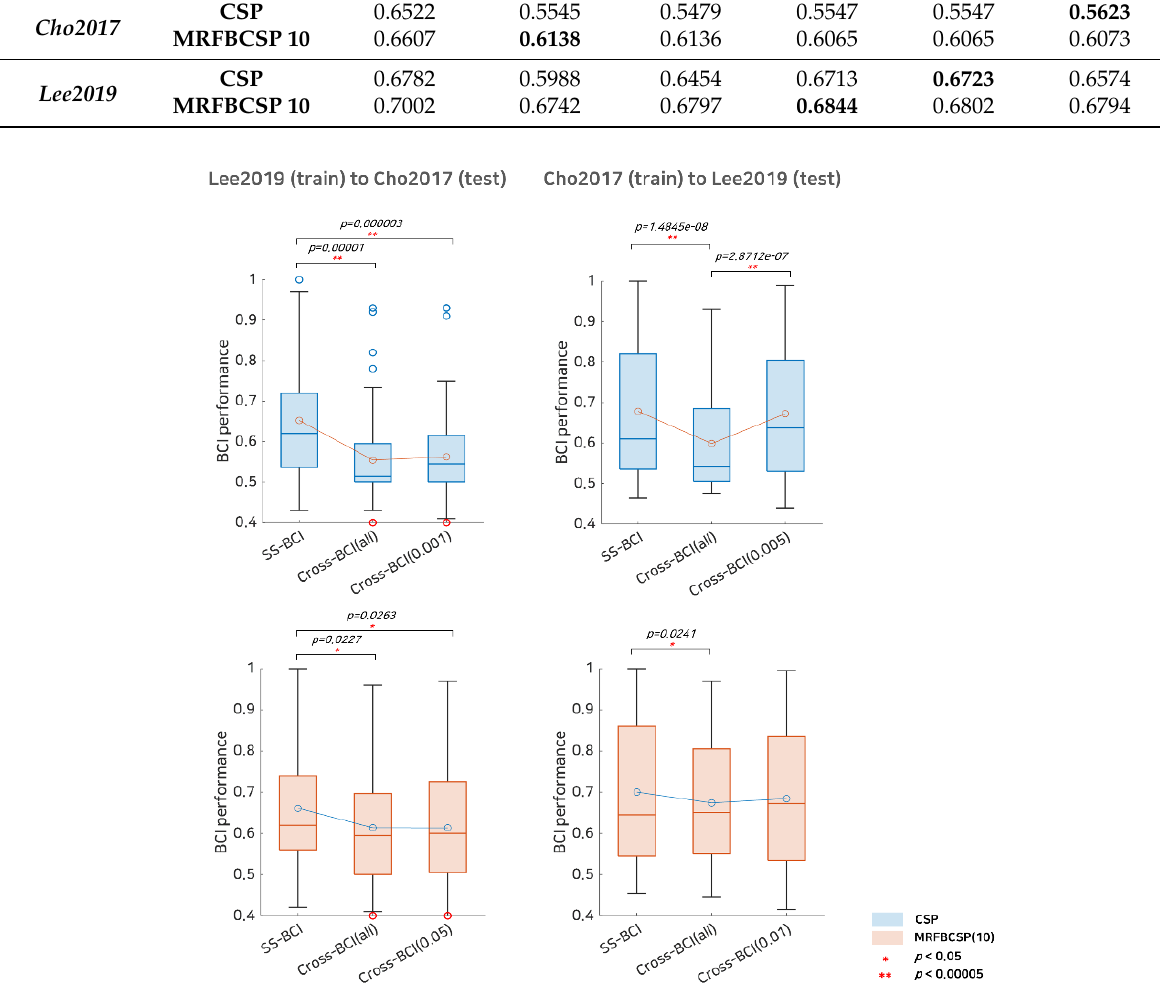
Figure 6. Comparative analysis of subject-specific BCI and cross-dataset BCI performance. This represents subject-specific BCI (SS-BCI) performance, cross-dataset BCI performance using all subjects available (Cross BCI-All), and cross-dataset BCI performance using selective subject training (Cross BCI- α ) for each dataset. The blue colored boxplots indicate the CSP method and the red colored boxplots denote the MRFBCSP method. Blue colored circles in the boxplot denote outliers, and the red colored circles in Lee2019 (training) to Cho2017 (testing) indicates a subject (s35) who showed ipsilateral activation in CSP during motor imagery.